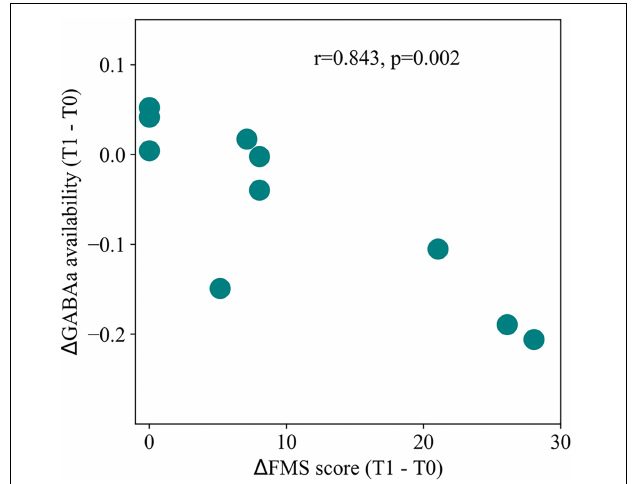
FIGURE 2 | Post-stroke changes in inhibitory signaling. Correlation between motor recovery, quantified through Fugl-Meyer scores (FMS), and changes in GABAa receptor availability in the contralesional cortex, measured with positron emission tomography. Decreases in receptor availability were strongly correlated with improved motor function, illustrating the importance of increasing excitability through plasticity of inhibitory synapses for functional recovery. T0 and T1 represent 1 and 3 months post-stroke, respectively. Adapted from Kim et al.